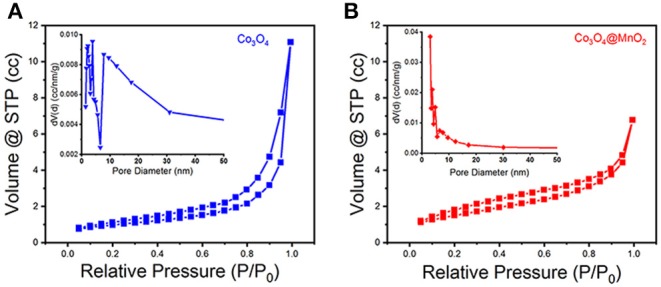
N2 adsorption-desorption isotherms of (A) Co3O4 and (B) Co3O4@MnO2 products. Inset shows their corresponding pore size distributions.